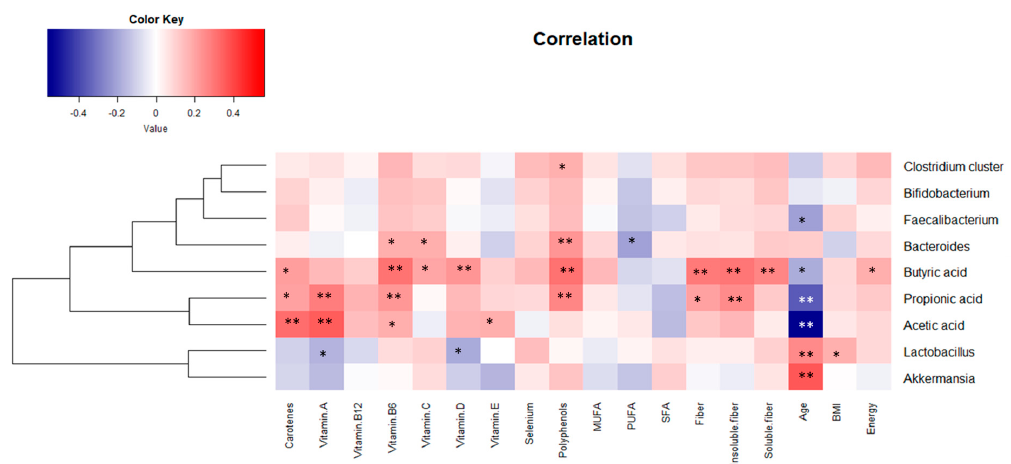
Figure 2. Pearson correlation between age and dietary compounds with the intestinal microbial groups and short chain fatty acids (SCFAs). The intensity of the colors represents the degree of association between the variables measured and asterisks indicate significant associations. * p < 0.05; ** p < 0.01. SFAs, saturated fatty acids. MUFAs, monounsaturated fatty acids. PUFAs, polyunsaturated fatty acids.